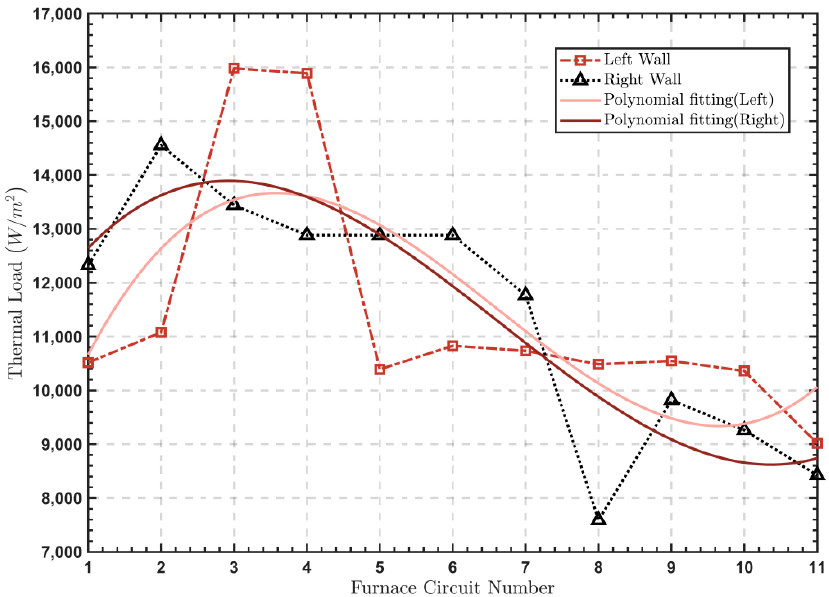
Figure 11. Average Thermal Load Distribution Along Height Direction.